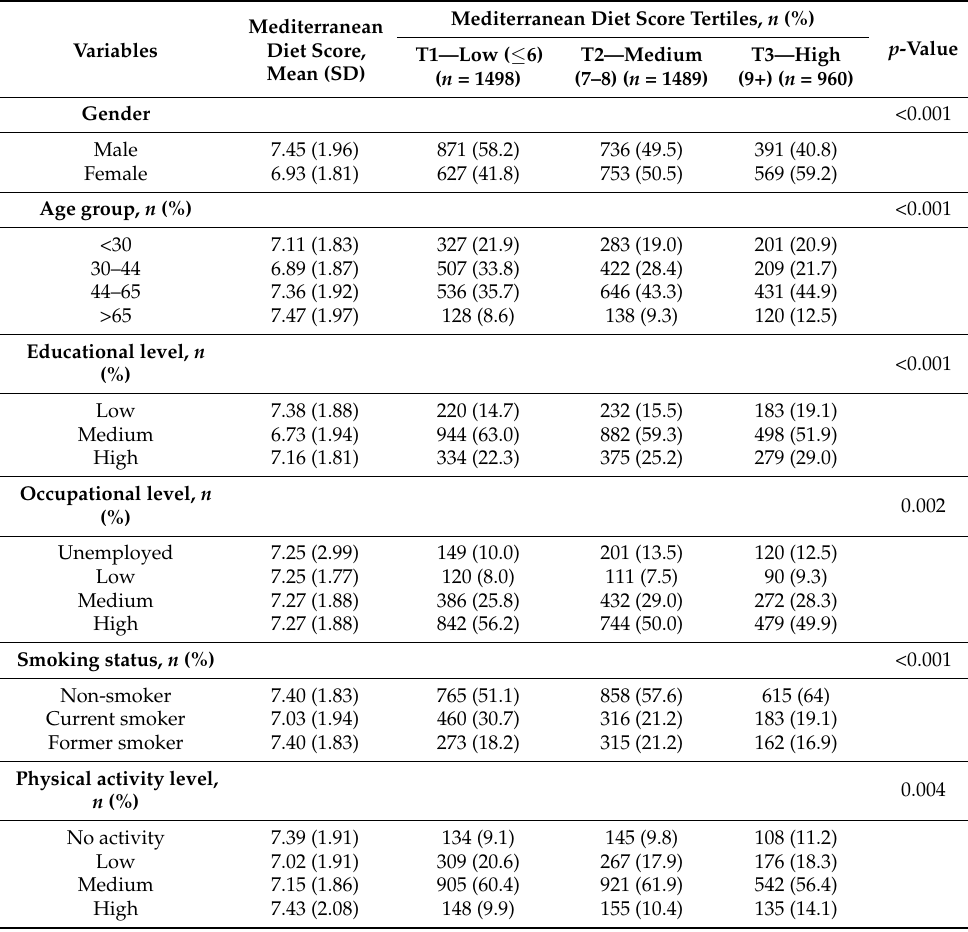
Table 1. Mediterranean diet adherence scores by demographic, socioeconomic, and lifestyle charac- teristics of the study sample ( n =